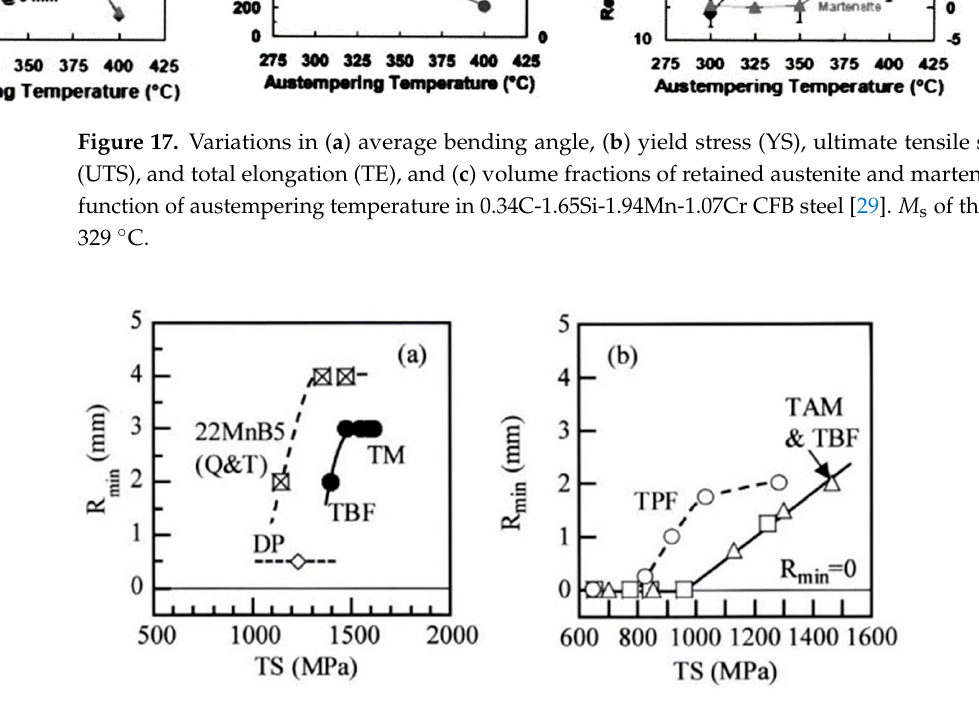
Figure 19. Variations in minimum bending radius ( R min ) as a function of isothermal transformation temperature ( T IT ) in ( a ) TAM and ( b ) TPF steels with the chemistry of 0.19C-1.54Si-1.51Mn-0.04Al (0Al), 0.20C-0.99Si-1.51Mn-0.49Al (0.5Al), and 0.20C-0.49Si-1.50Mn-0.99Al (1.0Al) [75]. ( a ) and ( b ) are reprinted with permission from ISIJ, copyright 2022. 7. Summary and Perspectives Partial replacement of Si by Al improves the coatability (or galvanizing property) of steel sheets, in the same way as P. Therefore, many researchers hope to know the effect of